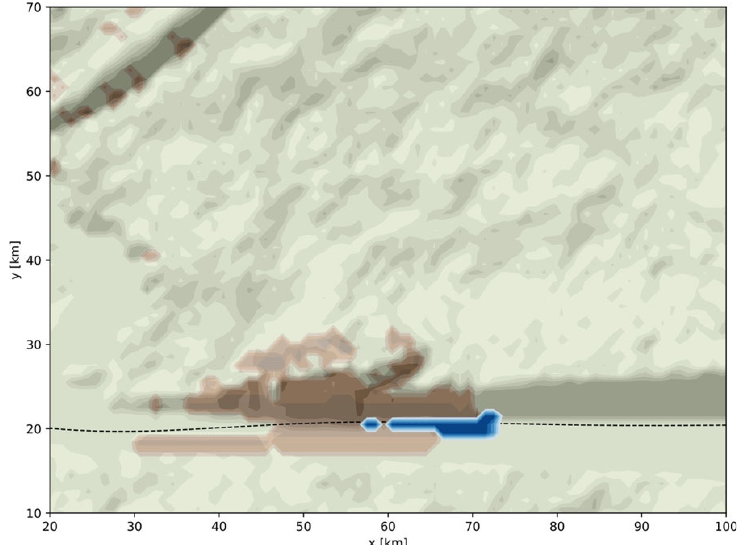
Figure 9. Detail of part of the digital template where a “quake lake” is generated, result of the cascade: earthquake EQ2 → landslides LS2 → river flood FL4. Realized for a modified parameterization of the digital template ( A river = 2 km, all other parameters remaining the same). The displaced soil is represented in brown and the accumulated water in blue.